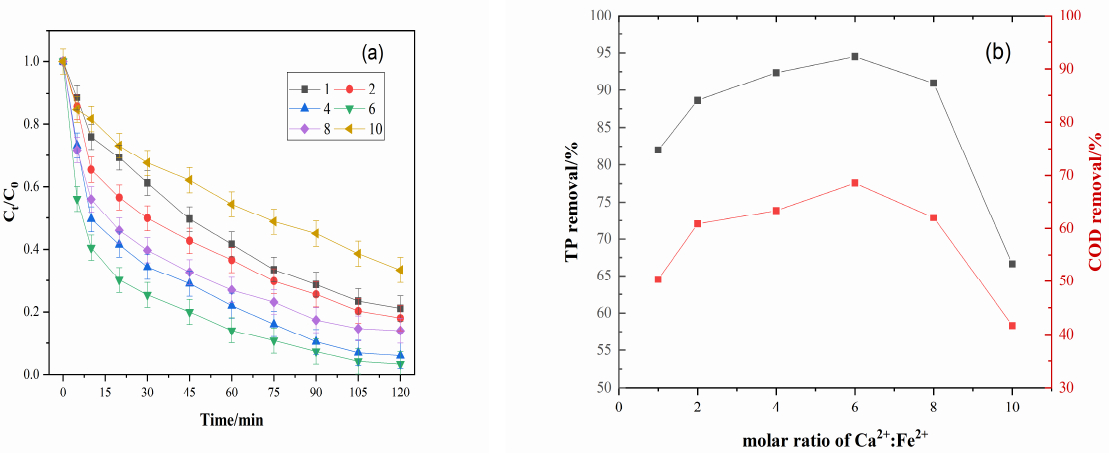
Figure 7. ( a ) Effect of the molar ratio of Ca 2+ :Fe 2+ on glyphosate removal; ( b ) Effect of the molar ratio of Ca 2+ :Fe 2+ on TP and COD removal (initial CaO 2 dosage = 0.5 g, 100 mL 50 ppm glyphosate solution, 150 rpm, pH = 3.0, RT = 25 °C, contact time = 120 min).